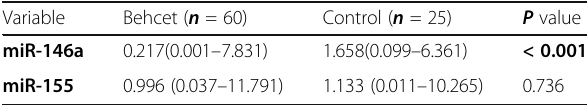
Table 6 Comparison between BD patients and control regarding level of miR146a and miR155expression